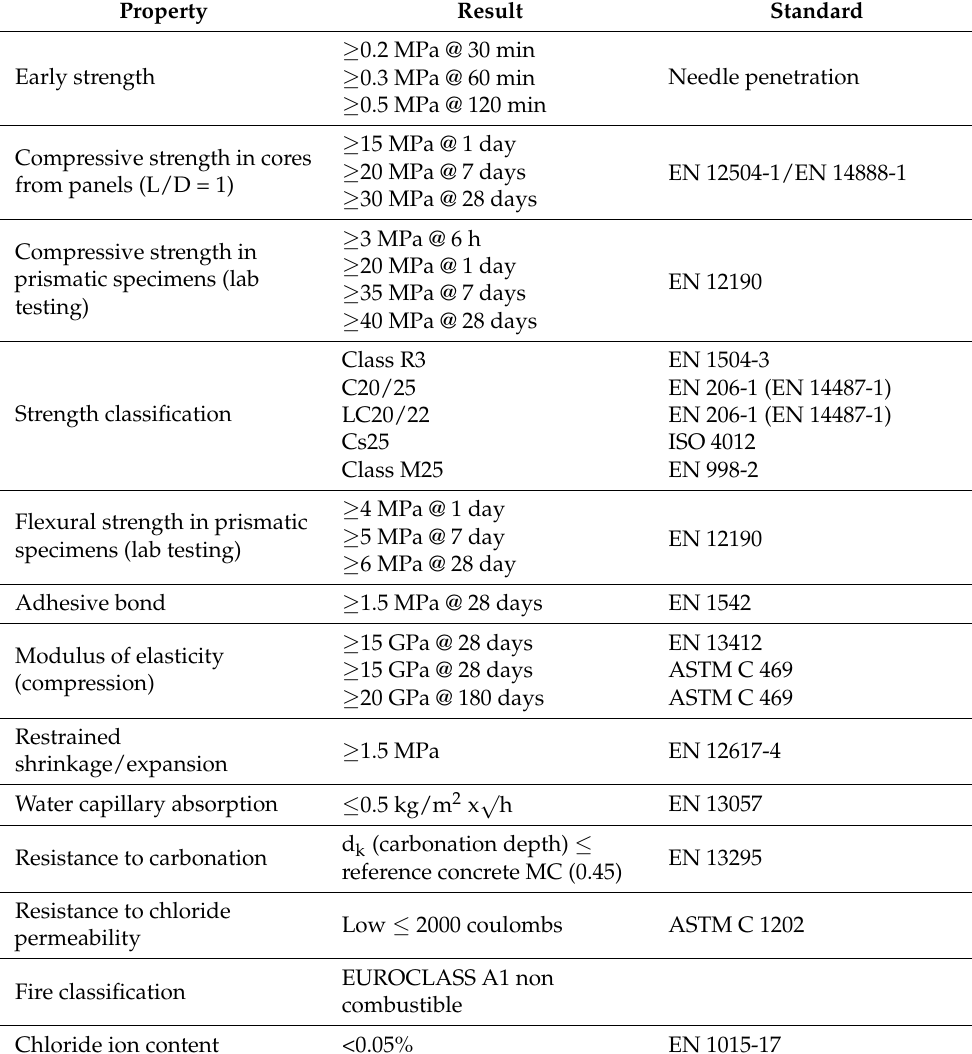
Table 4. Technical properties of GUNITECH ®